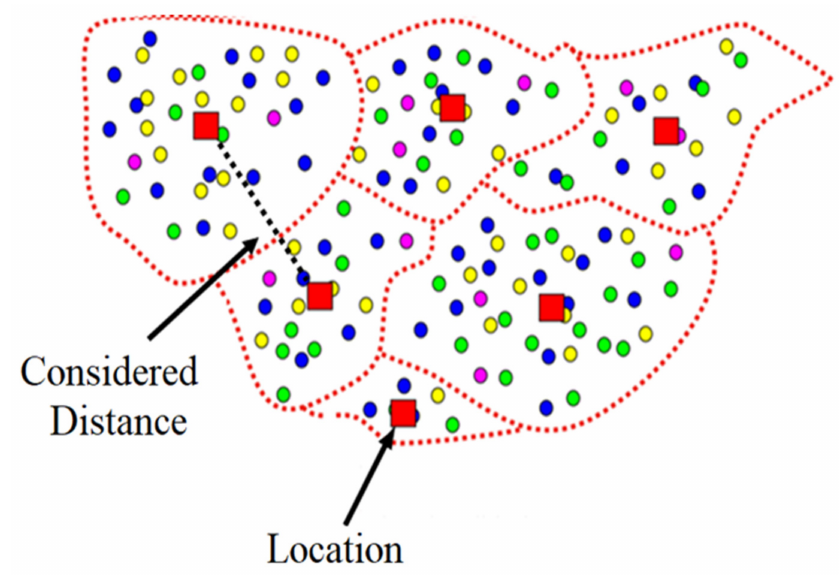
Figure 4. Division of a territory into multiple